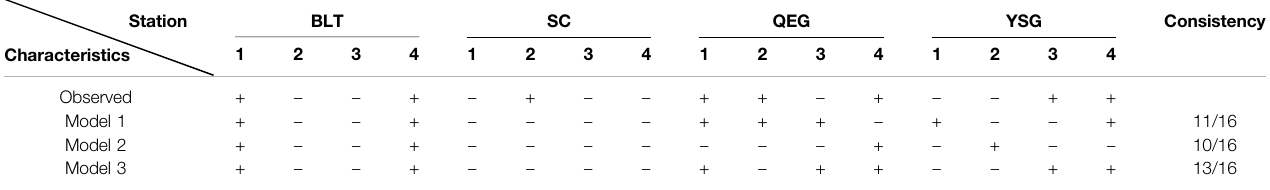
TABLE 4 | Comparison of the predicted and observed tensile and compressive characteristics of the coseismic strain steps